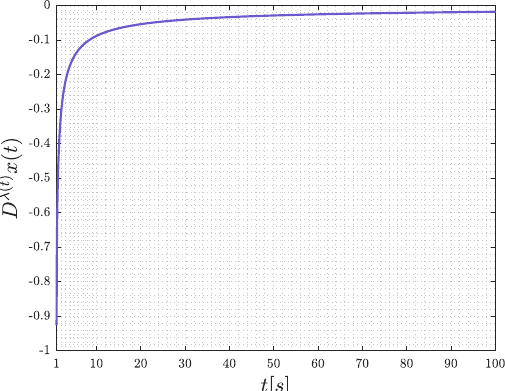
Figure 3. D λ ( t ) x ( t ) (Equation (50)) with α = 0.65, β = 0.5, and γ = −